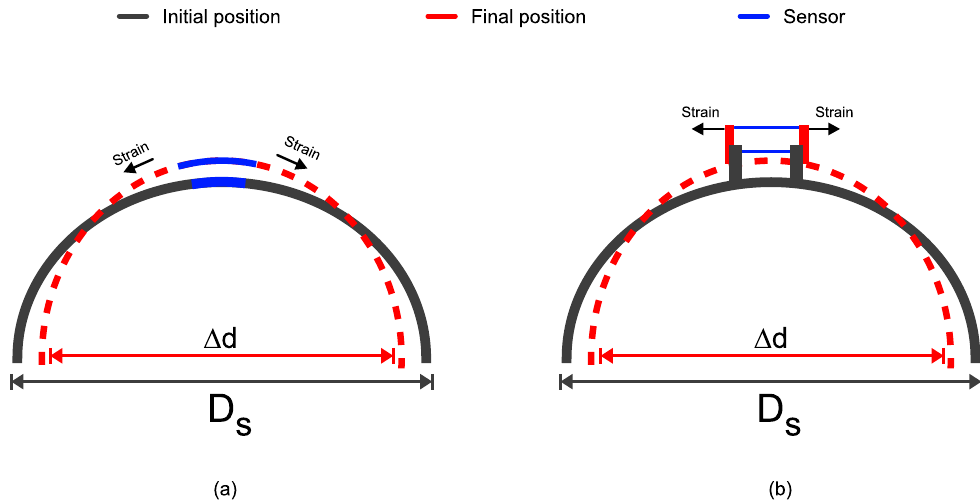
Figure 7. Mechanical operation ( a ) piece without supports; ( b ) piece with supports.